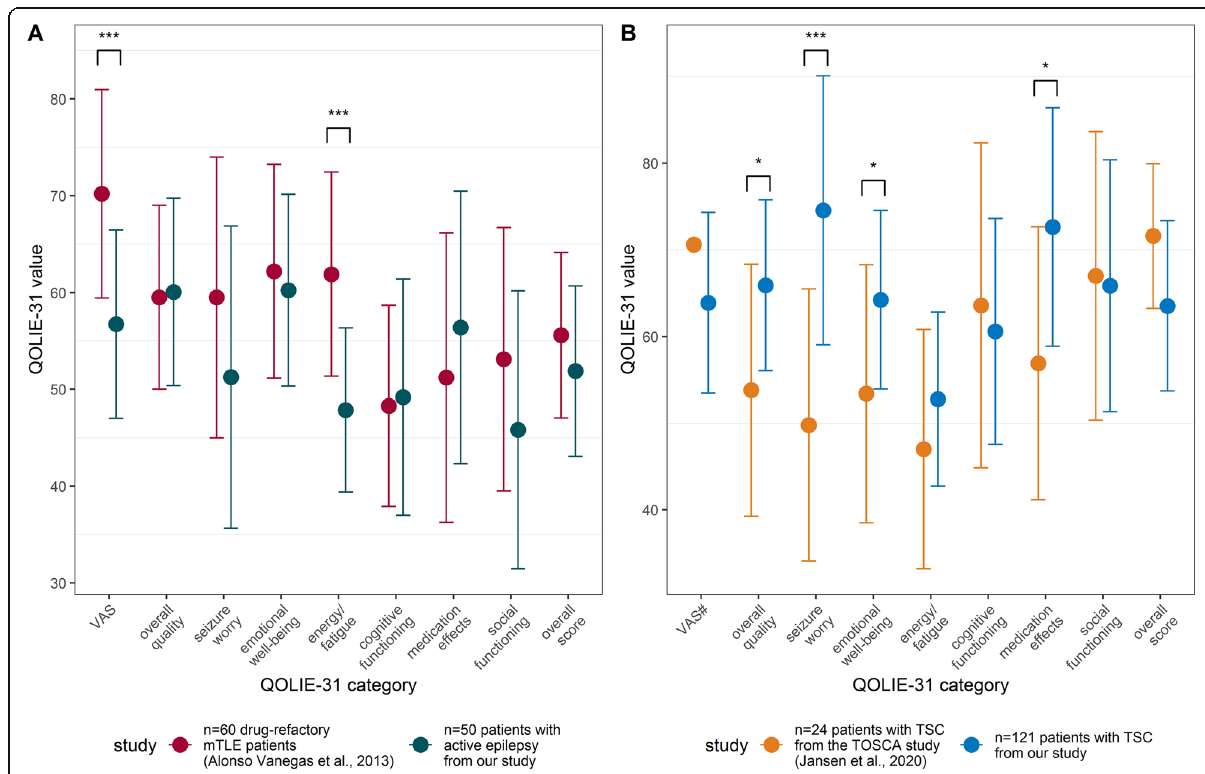
Fig. 2 Health-related quality of life in our TSC cohort compared with other cohorts with epilepsy. A: Comparison of health-related quality of life (HRQoL), as assessed by the Quality of Life in Epilepsy Inventory-31 items (QOLIE-31) between a study on patients with drug-refractory mesial temporal lobe epilepsy and individuals from our tuberous sclerosis complex (TSC) cohort with active epilepsy (defined as experiencing seizures within the last 12 months). The TSC patients in our cohort demonstrated a lower overall health status compared with temporal lobe epilepsy patients, as measured by the visual analogue scale (VAS) component of the QOLIE-31. Fatigue was higher among TSC patients than temporal lobe epilepsy patients. B: Comparison of patients with TSC, both with and without epilepsy, between the TOSCA registry and our overall cohort. The QOLIE-31 overall quality of life subscore was significantly worse in the TOSCA cohort, seizure worry was higher, emotional well-being was worse, and medication effects were higher among the TOSCA cohort compared with our cohort, with all other categories demonstrating similar values. #Standard deviation for the VAS scale of the questionnaire was not reported by Jansen et al. Independent samples t -tests, * = p < 0.05, ** = p < 0.01, *** = p <